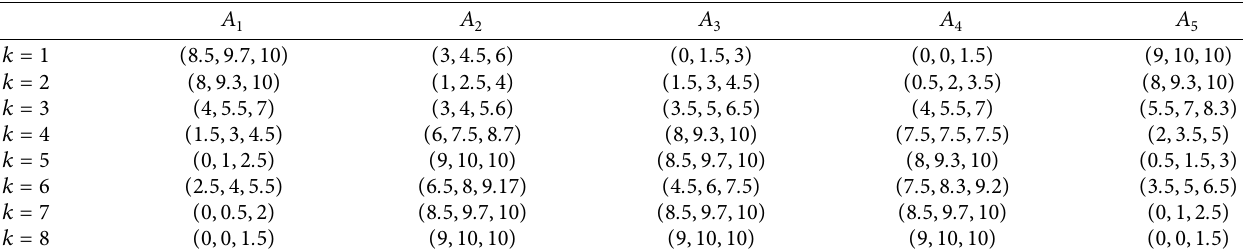
Table 16: LSI logistics service capability scoring information when decoupling points are in different positions: described by fuzzy numbers.